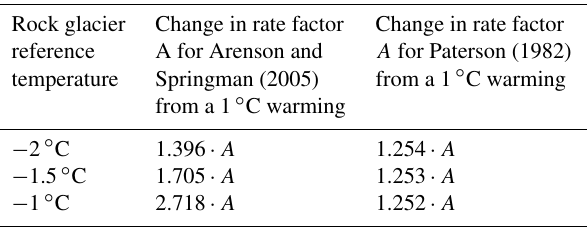
Table 5. Multiplicative increase in rate factor A from a 1 ◦ C rock glacier warming for the different temperature relations of Arenson and Springman (2005) and Paterson and Budd (1982) and varying rock glacier reference